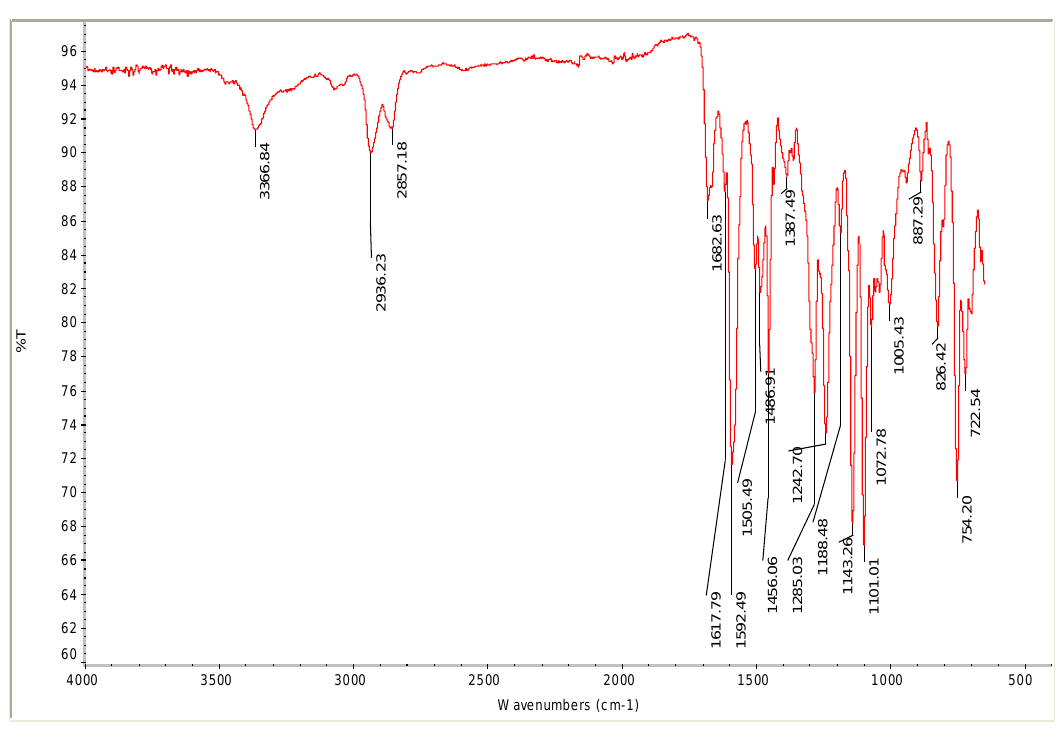
Figure S5: FT-IR spectrum of dialdehyde monomer o -HOA